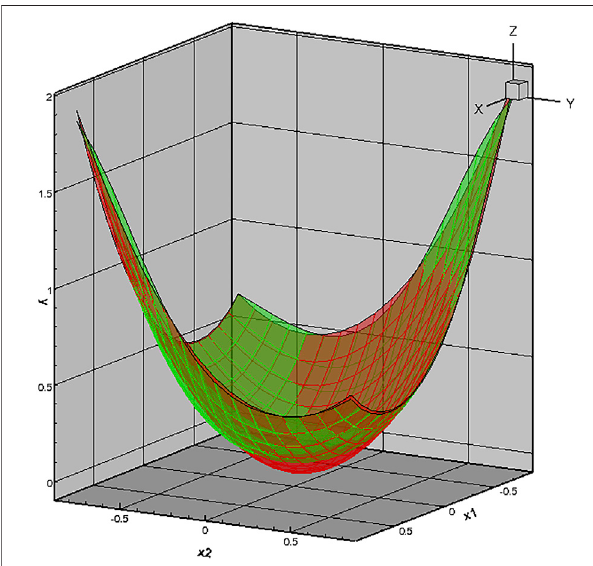
FIGURE 5 | Comparison between actual surface and fi tting surface.